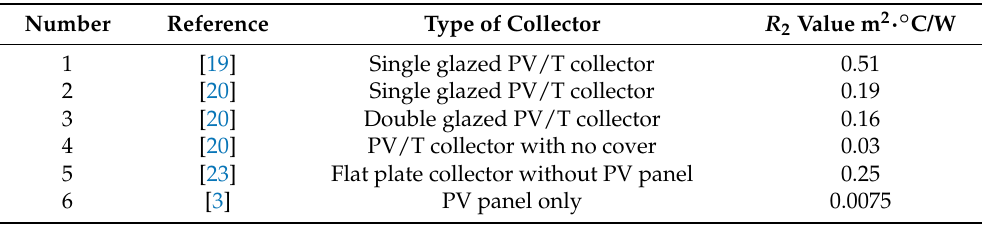
Table 2. Thermal resistance of different types of rooftop PV/thermal collectors.